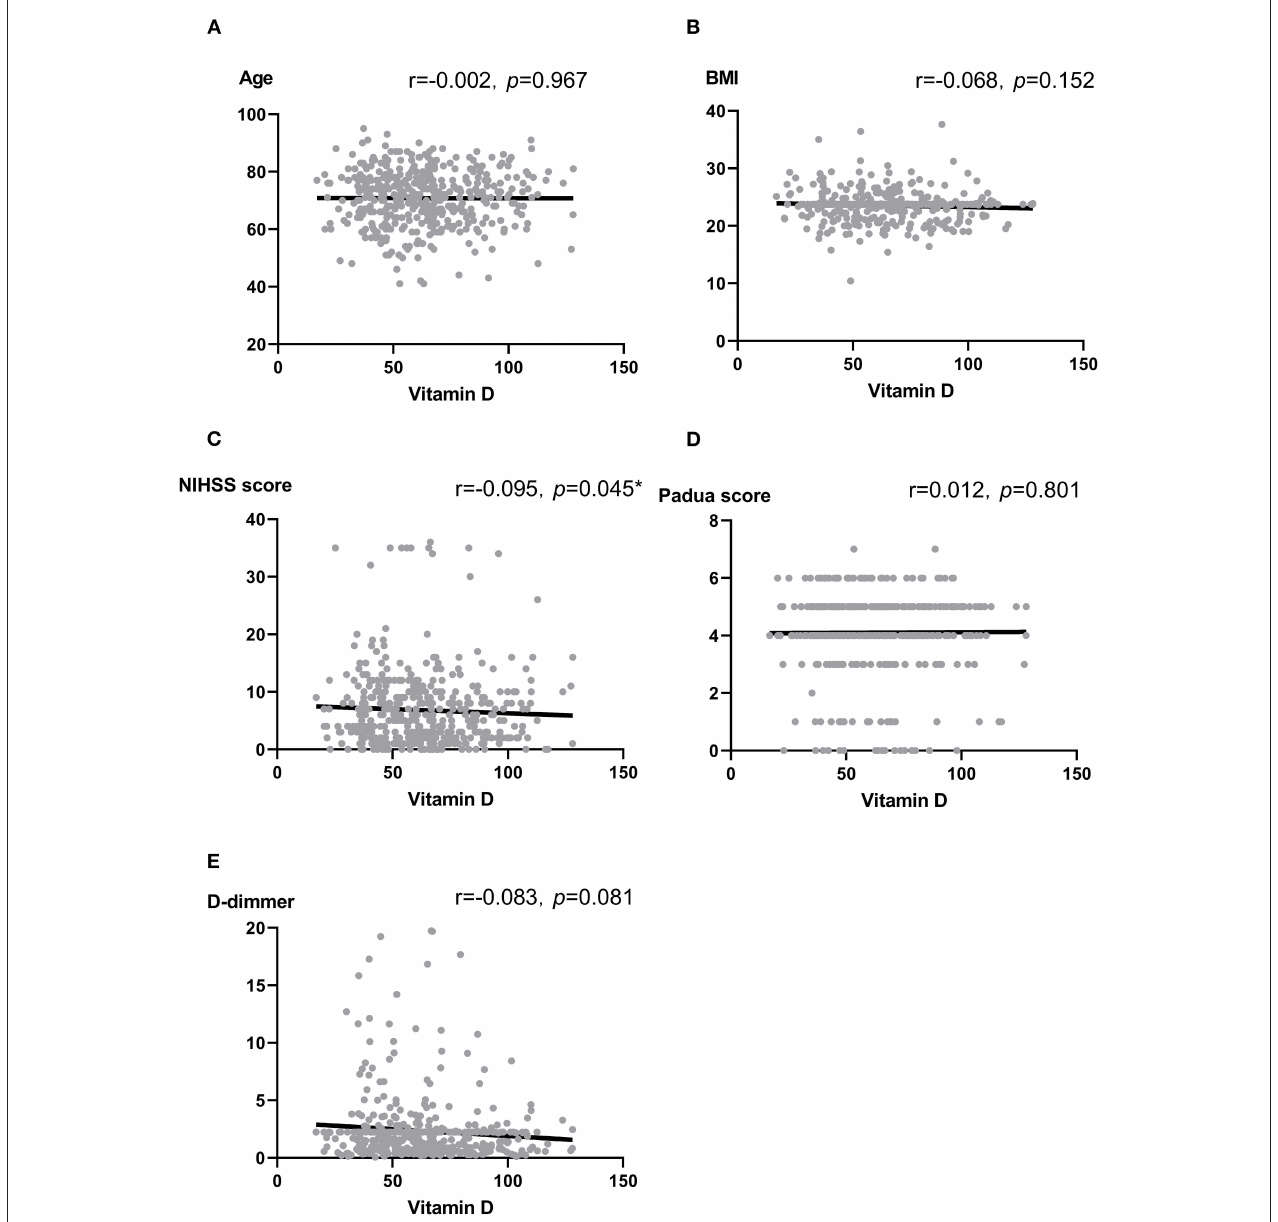
FIGURE 1 | (A–E) Scatter plots: Association between vitamin D and Age (A) , BMI (B) , NIHSS score (C) , Padua score (D) as well as D-dimmer (E) . Note: r, correlation coefficient; BMI, body mass index; NIHSS, National Institute of Health stroke scale. Pearson correlation and Spearman analysis were used to evaluate the correlation according to the type of data. * p <